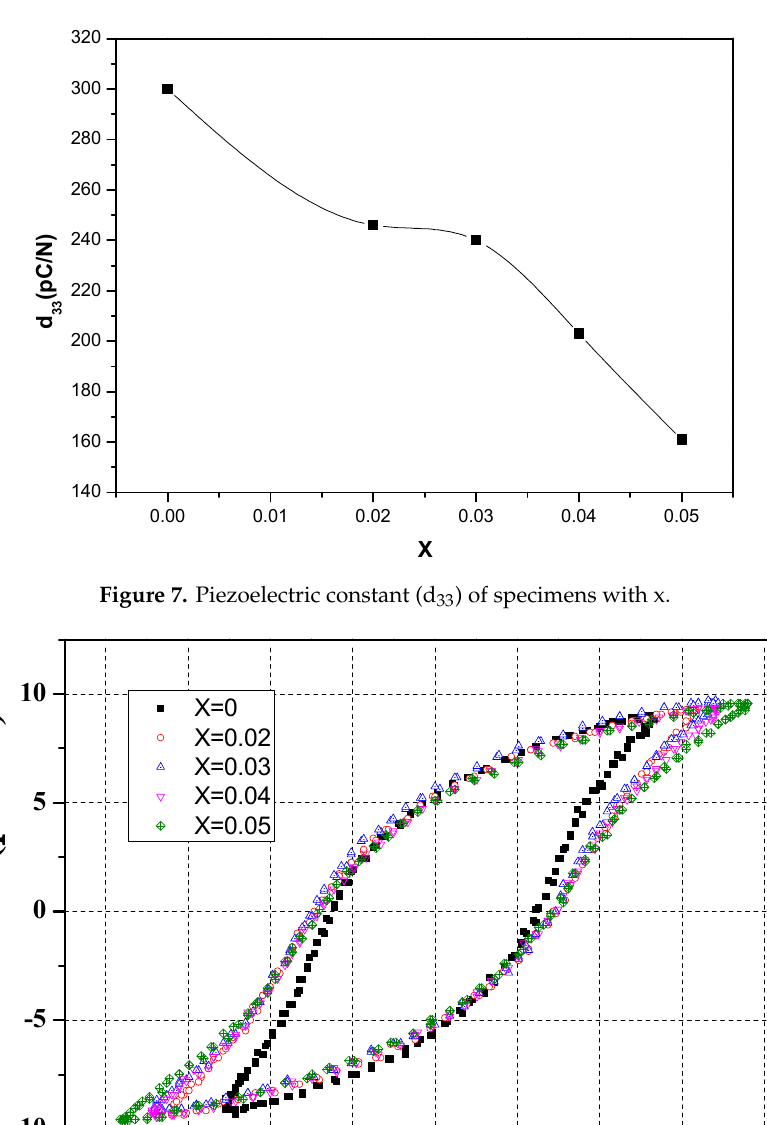
Figure 8. P-E hysteresis curve of specimens with x.